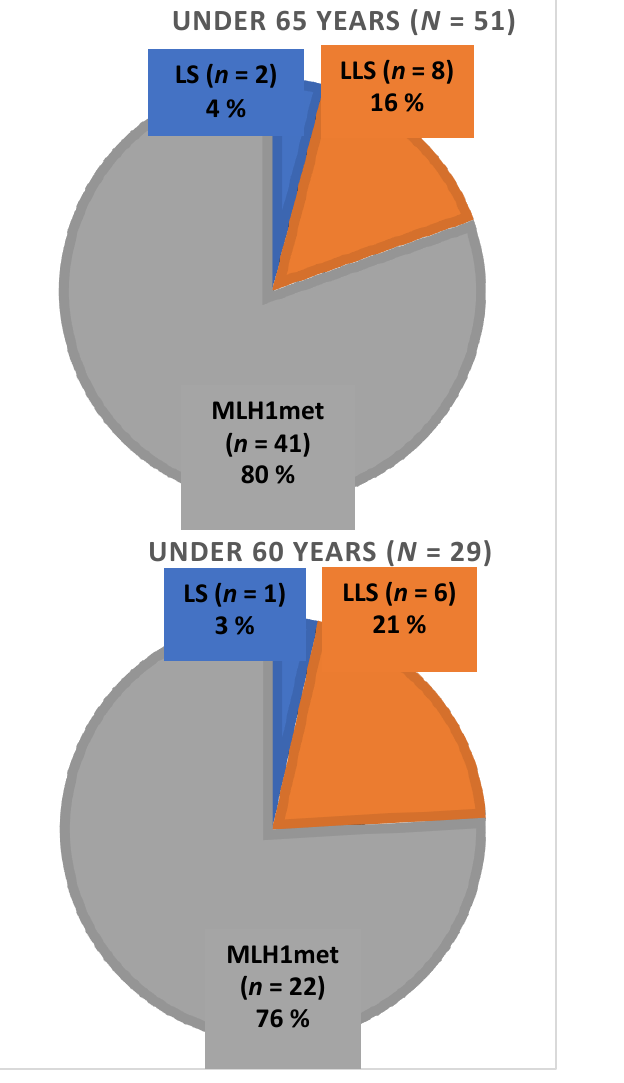
Figure 2. Prevalence of LS, LLS and methylation-linked MLH1-deficient endometrial carcinoma according to age groups (total n = 174